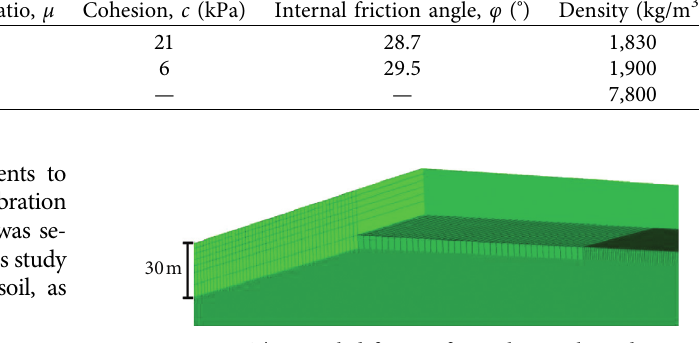
Figure 2: The coupled finite infinite element boundary.